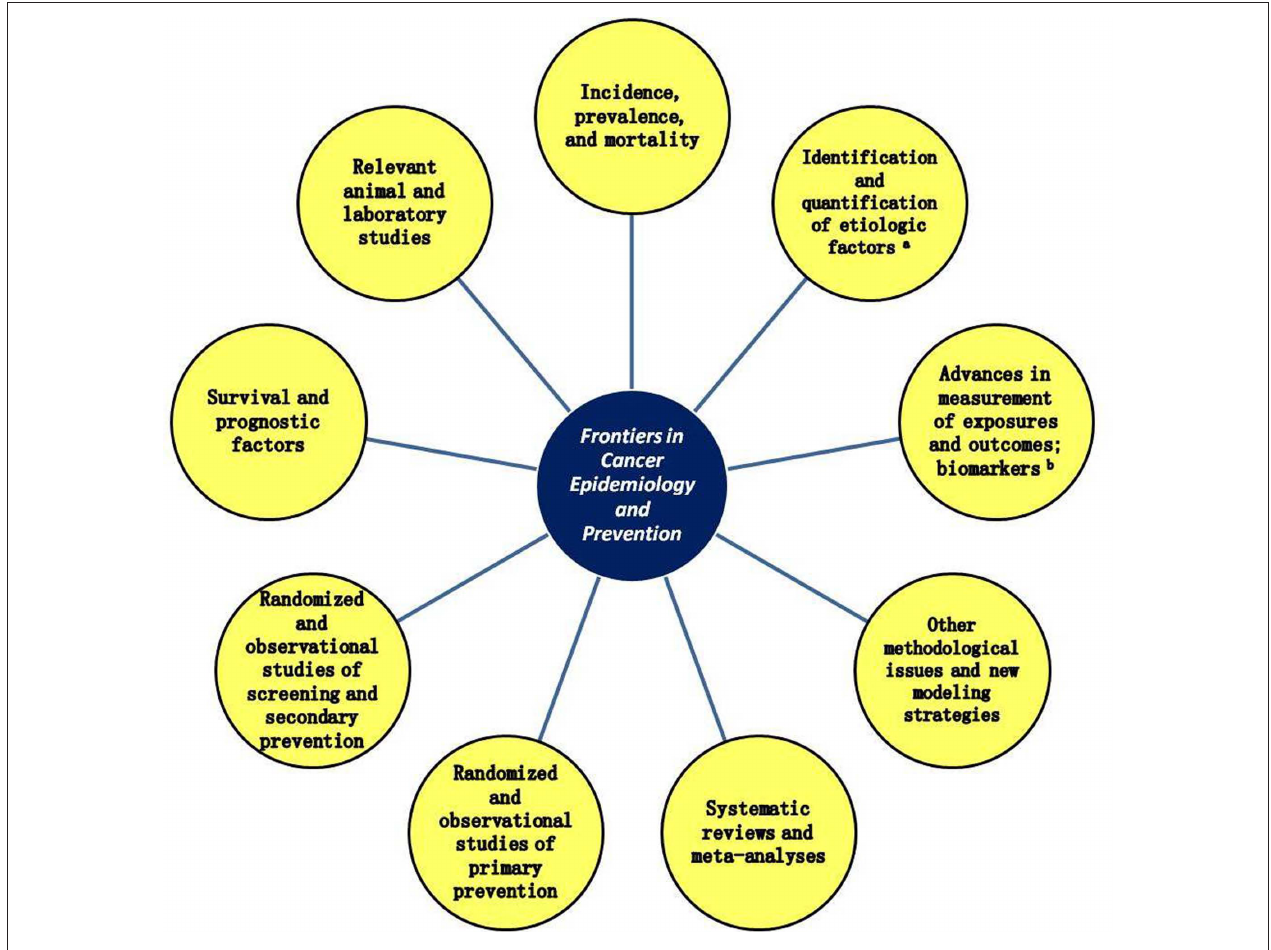
Figure 1 | Cancer research areas that are within the scope of Frontiers in Cancer Epidemiology and Prevention *. * Null results from high-quality studies are also welcome. a Including environmental, genetic, and epigenetic factors and their interactions. b Including advances in data collection methods and biomarkers, as well as translational